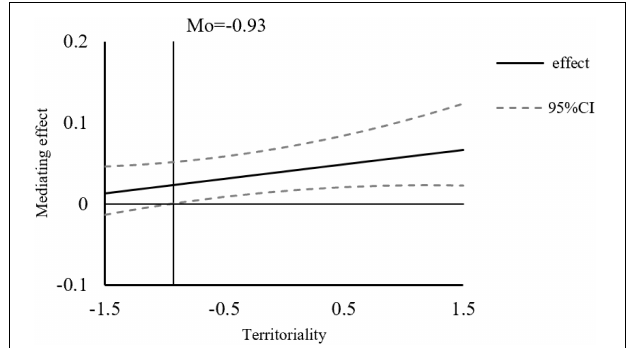
FIGURE 6 | Moderated mediating effect and confidence interval of perpetrator sensitivity.